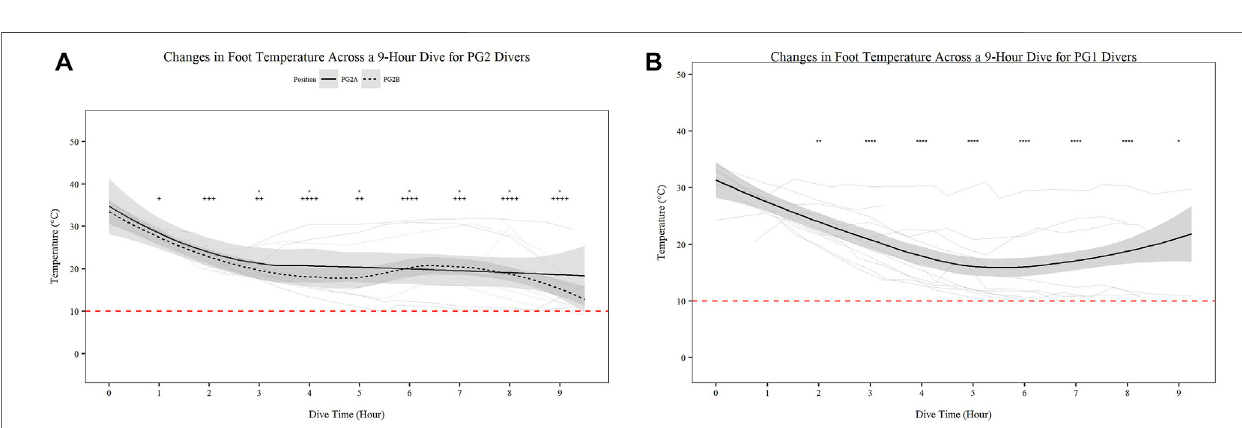
FIGURE 4 | Changes in Foot Temperature across a 9-h Dive for PG2A and PG2B (A) and PG1 (B) divers. Changes in foot temperature for each diver across each dive are represented. PG2B are depicted as solid lines; and PG2A are depicted as dashed lines. The red dashed line represents the 10 ° C, the point of risk for non- freezing cold injuries. * p < 0.05, ** p < 0.01, *** p < 0.001, **** p < 0.0001; * = PG2A, + = PG2B. All comparisons are in relation to Hour 0. Trend line created using loess function with standard error